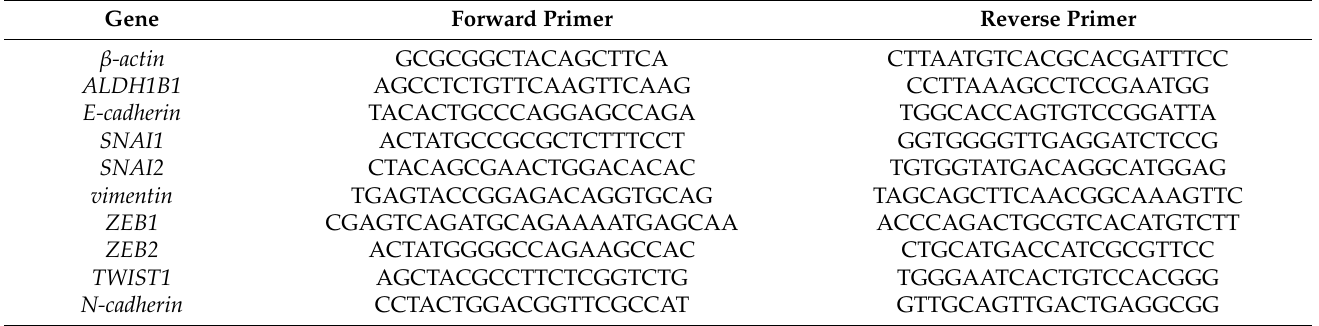
Table 1. Primers used for real-time PCR comparative